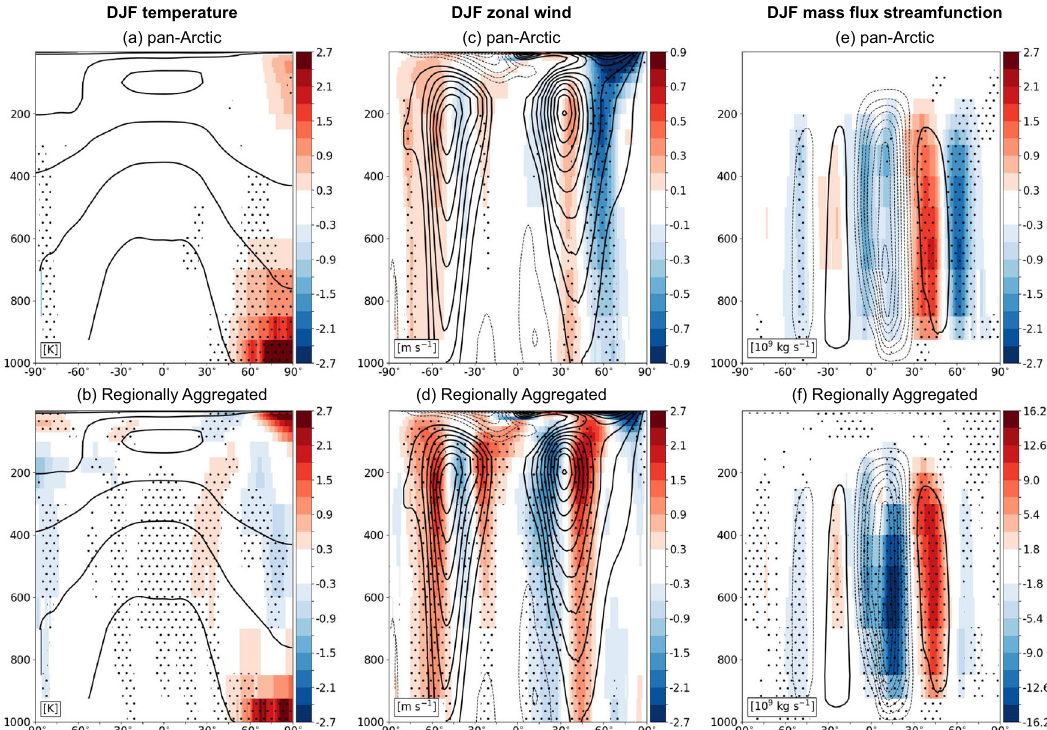
Fig. 3 Pan-Arctic vs. regionally aggregated zonal-mean response to future Arctic sea-ice loss. Zonal-mean anomalies of: a , b temperature, c , d zonal wind, and e , f meridional streamfunction in the pan-Arctic experiment (top row) and aggregated signal from all regional experiments (bottom row). Anomalies (shown in colors) are computed as the difference between the future experiments and the present-day experiment climatologies. The present-day climatology is shown in black contours in increments of 25 K ( a , b ), 4 m s − 1 ( c , d ), and 25 × 10 9 kg s − 1 ( e , f ), with dashed and solid lines for negative and positive values, respectively. All panels are pressure level [hPa] – latitude [deg] cross-sections. Dotted areas indicate regions where the sign of the anomalies agrees in at least 95% of the 1000 bootstrapped heat capacity of dry air at constant pressure per unit mass, L v the latent release of vaporization per unit mass (here we disregard the